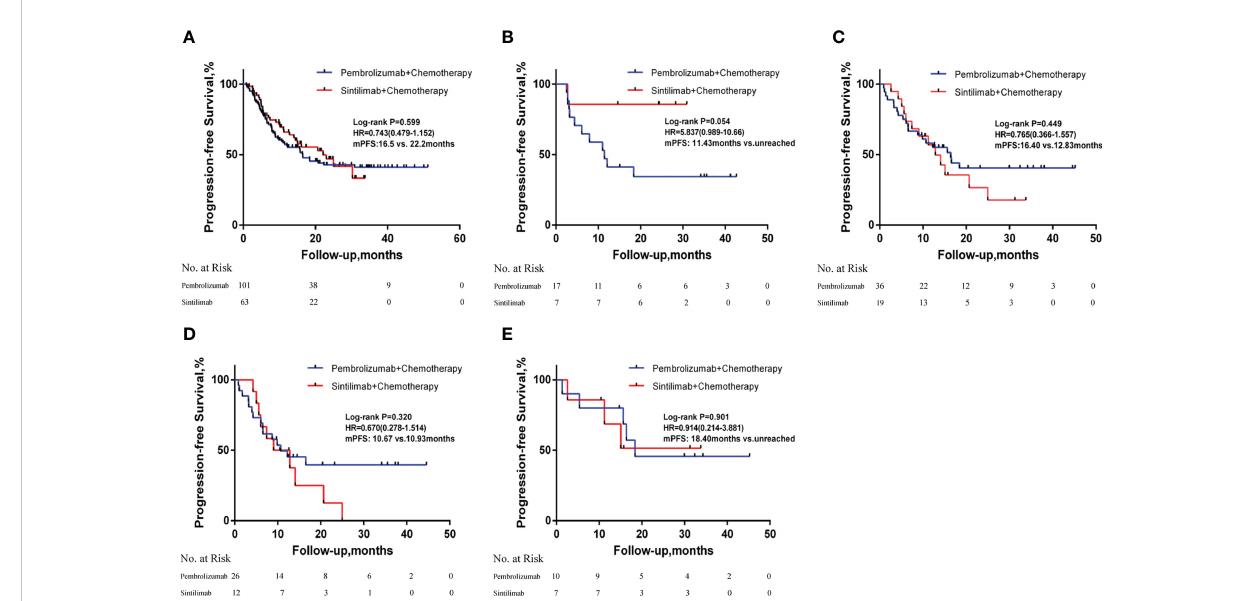
FIGURE 1 Kaplan-Meier curves of progression-free survival in (A) all patients; (B) patients with negative PD-L1 expression; (C) patients with positive PD-L1 expression; (D) patients with low PD-L1 expression and (E) patients with high PD-L1 expression.HR, hazard ratios; mPFS, median progression-free survival; PD-L1, programmed death-ligand 1.